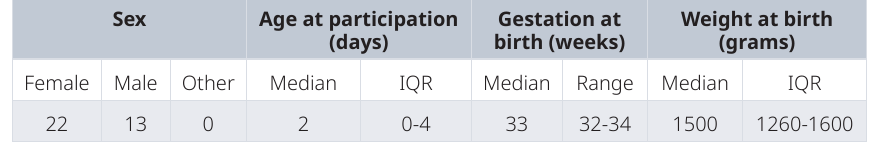
Table 2. Rules for identifying breaths based on graphical waveform plots. 1. Count peaks of the waveform that are within the white background. Ignore peaks that are within the grey background on either side of the image. 2. A peak should be counted as a breath when the peak of the waveform is above 15mmHg, the lower horizontal blue line. 3. If the peak does not reach the lower horizontal blue line at 15 mmHg, to be counted as a breath, the peak should reach at least 50% of the mean peak. 4. The waveform should dip down to the normal baseline (either below 15 mmHg, the lower horizontal blue line, or based on other breaths). If the waveform does not reach below this point, then this is considered part of the same (double) peak and only counted as a breath